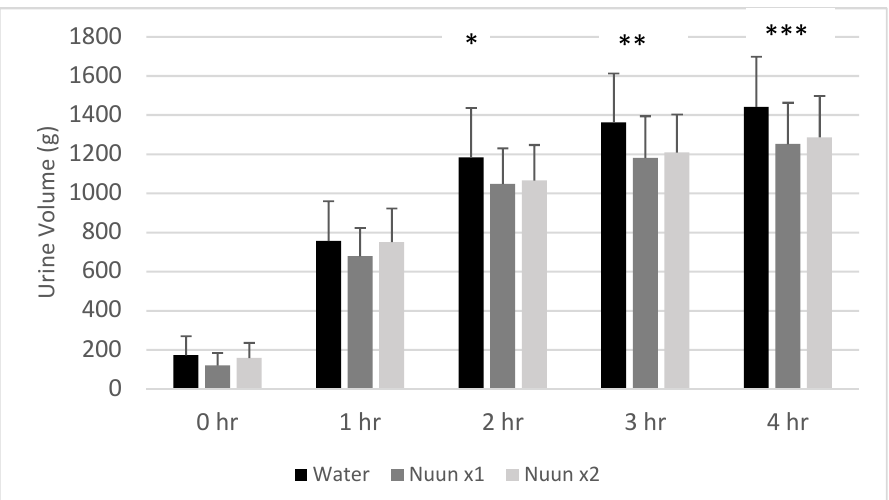
Figure 4. Cumulative urine volume of 18 men and women through four hours after consuming water only and Nuun+water; Values are mean ± standard deviation; hr is hour(s) after condition ingestion, Nuun x1 is Nuun beverage at normal concentration, Nuun x2 is Nuun beverage at double concentration; * Water higher than Nuun x1 (p = 0.03) and Nuun x2 ( p = 0.07); ** Water higher than Nuun x1 ( p = 0.004) and Nuun x2 ( p = 0.02); *** Water higher than Nuun x1 ( p = 0.003) and Nuun x2 ( p = 0.01); No other differences of statistical significance noted ( p > 0.05).